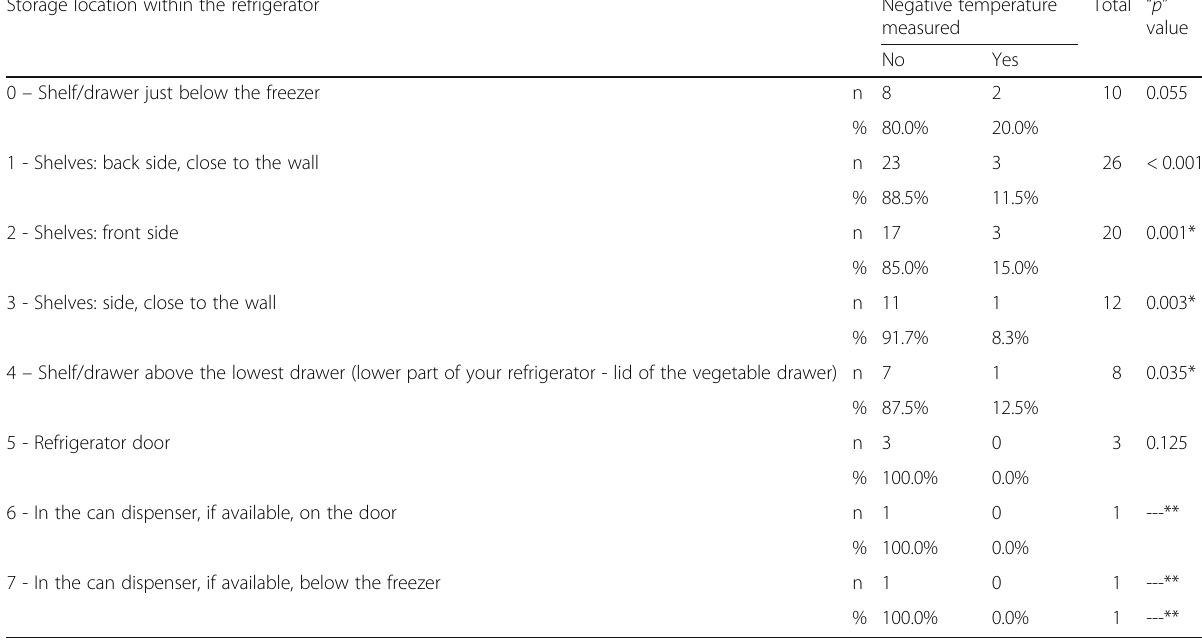
Table 4 Association between location of biological medications within a refrigerator and occurrence of negative temperatures Storage location within the refrigerator